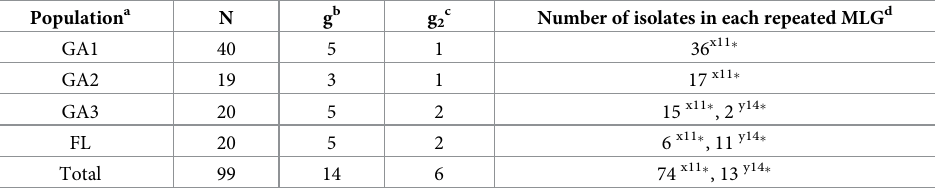
Table 4. Clonal composition of Fusarium oxysporum f. sp. niveum populations from the southeastern United Sates. Population